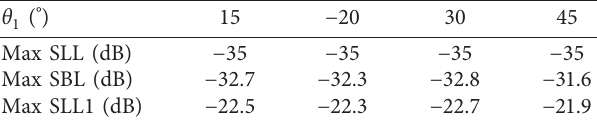
algorithm. The contrast effect of optimized patterns with different beamforming directions is shown in Figure 10.